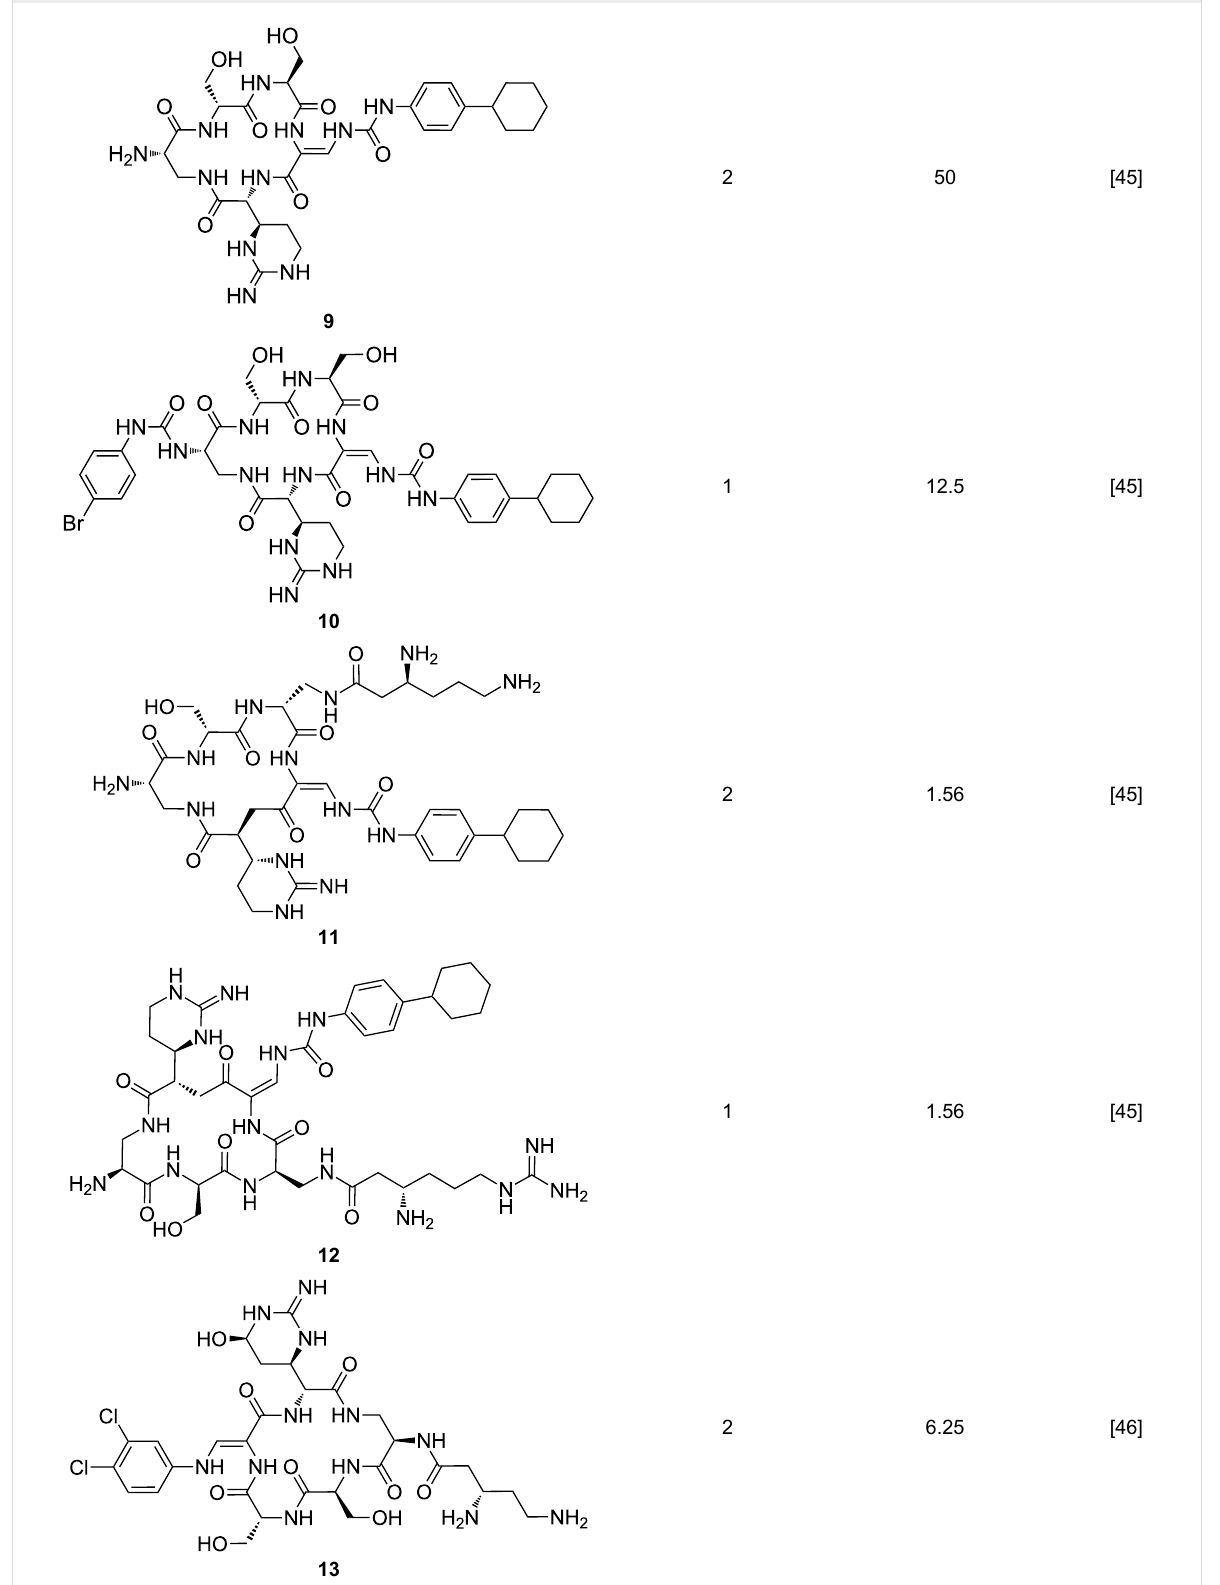
Table 1: Structures of cyclic peptides with their MIC values.